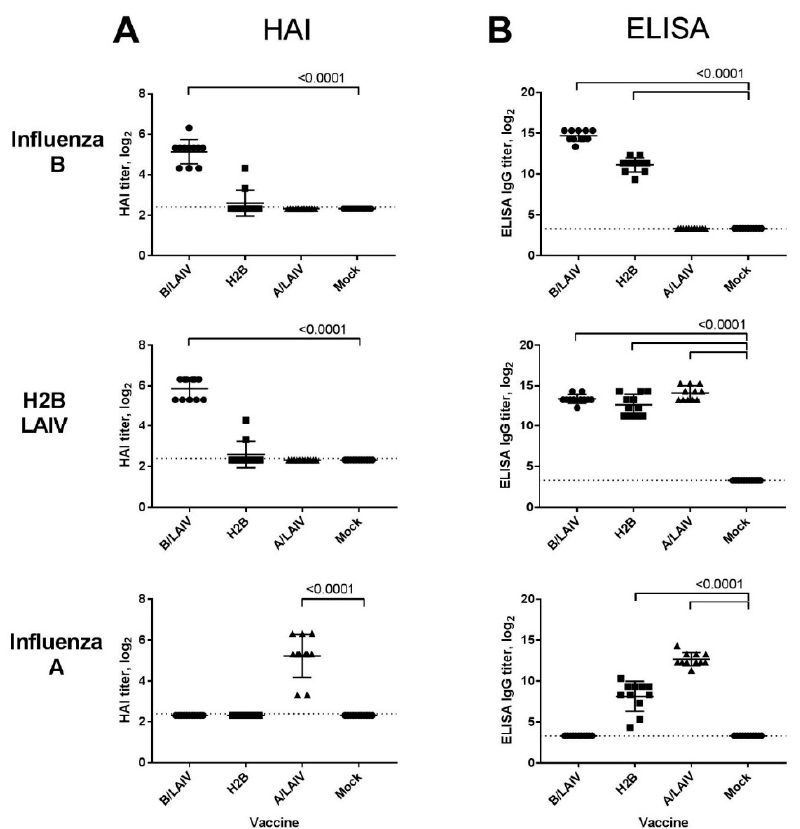
Figure 6. Serum antibody responses after immunization with the LAIVs studied: serum antibody titers were assessed 3 weeks after 2nd immunization. Titers were studied with 3 antigens (influenza B: B/Brisbane/60/2008; H2B LAIV; and influenza A: A/17/New York/2015/5364) in ( A ) hemagglutination inhibition (HAI) and ( B ) ELISA tests. Significant differences are indicated by dashes, p values are specified: HAI–Kruskal–Wallis ANOVA (Dunn’s multiple comparisons test); ELISA–ANOVA (Tukey’s multiple comparisons test).